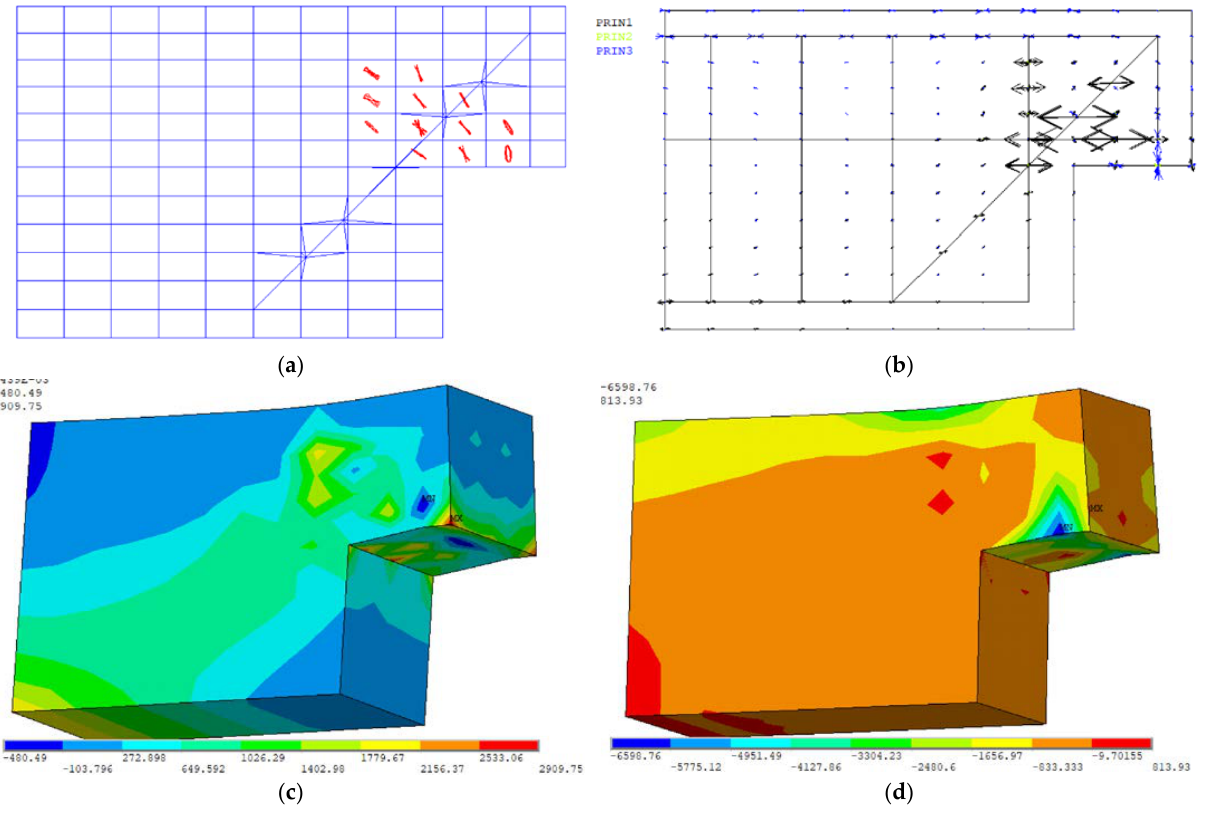
Figure 19. Half-joint in NS-RS configuration. ( a ) Cracking surfaces at collapse (97% final load); ( b ) vector plot of principal stresses just before collapse; ( c ) 1st principal stress just before collapse [kN/m 2 ]; ( d ) 3rd principal stress just before collapse [kN/m 2 ].